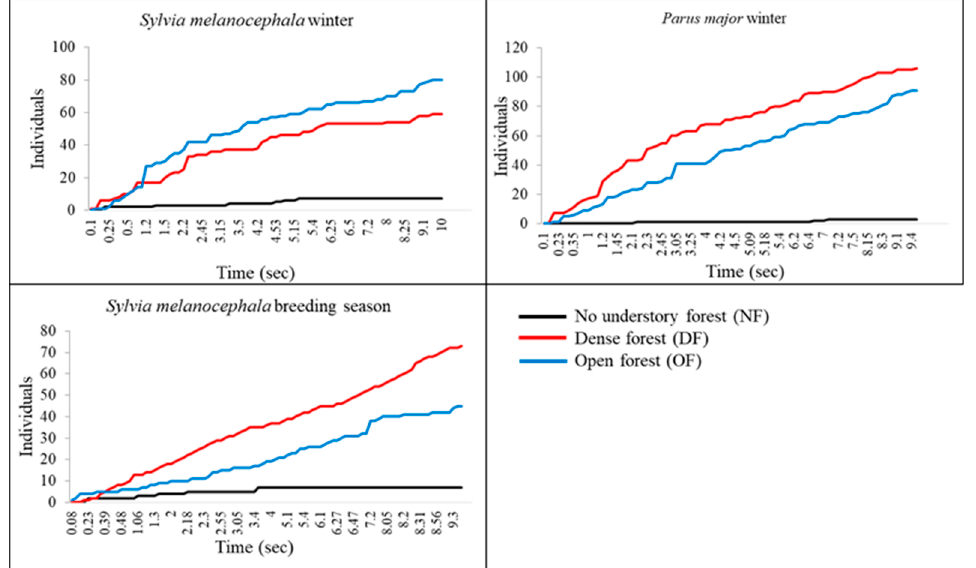
Figure 4. The accumulated number of responders throughout the experiment (the reaction level) with respect to different mobbing callers, forest habitats, and seasons.